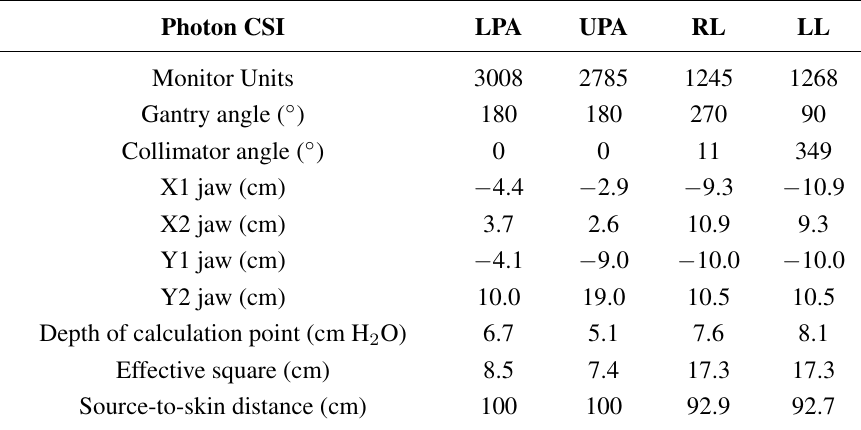
Treatment field characteristics for the photon CSI, with Monitor Units listed for D . Rx